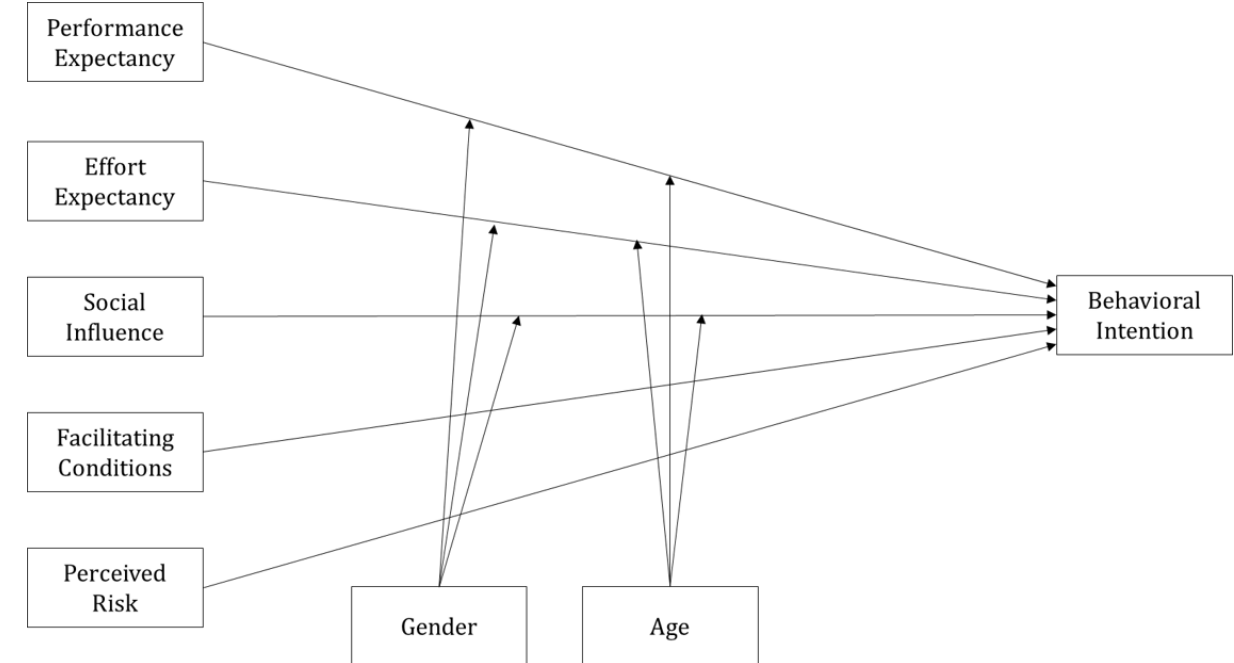
Figure 3. Research